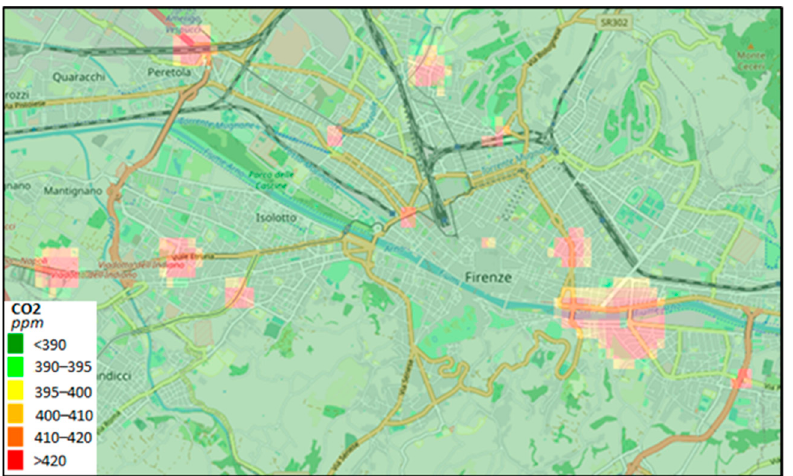
Figure 10. An example of a CO 2 heatmap in Florence Municipality. An interpolation method is applied to the CO 2 data, which are estimated in accordance with Equation (1) at the traffic sensor locations depicted in Figure 2b. The traffic data are simultaneously measured in sparse locations at 8 a.m. on a spring workday. Accessible on Snap4city.org https://www.snap4city.org/dashboardSmartCity/view/index.php?iddasboard=MTUzMg== (accessed on 27 April 2022).